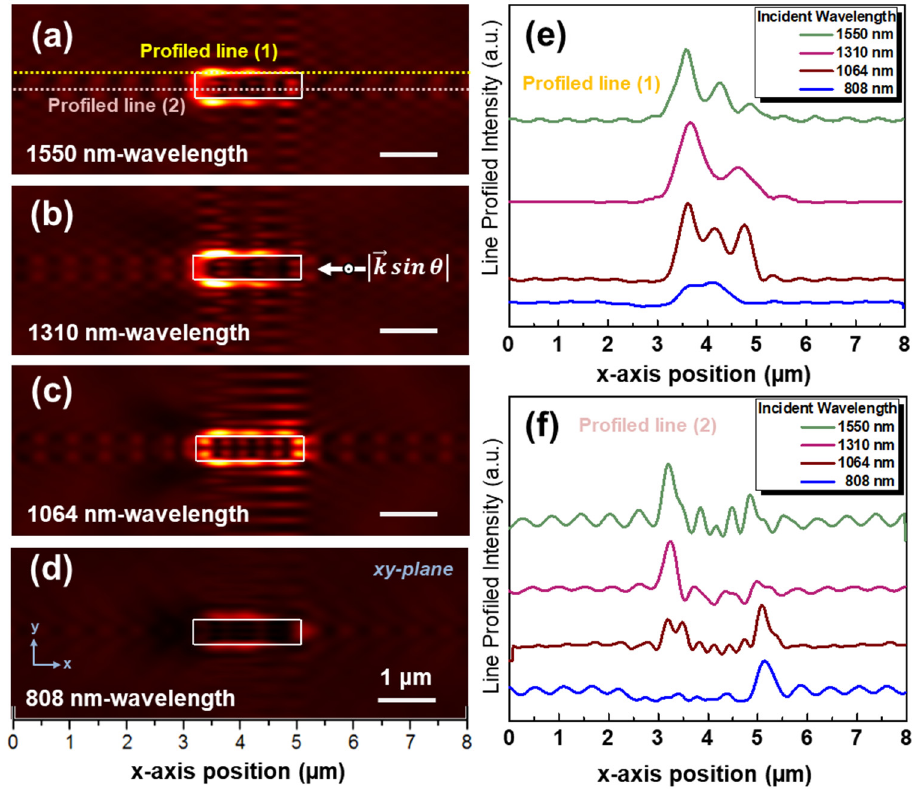
Figure 2. Simulation results of plasmonic near-field electromagnetic fields distributions for I-shaped nanostructure arrays by incident light with wavelengths of ( a ) 1550, ( b ) 1310, ( c ) 1064, and ( d ) 808 nm. Intensities of localized electromagnetic fields at ( e ) the edge (profiled line (1)) and ( f ) the center (profile line (2)). The information of incident light source is indicated in ( b ).